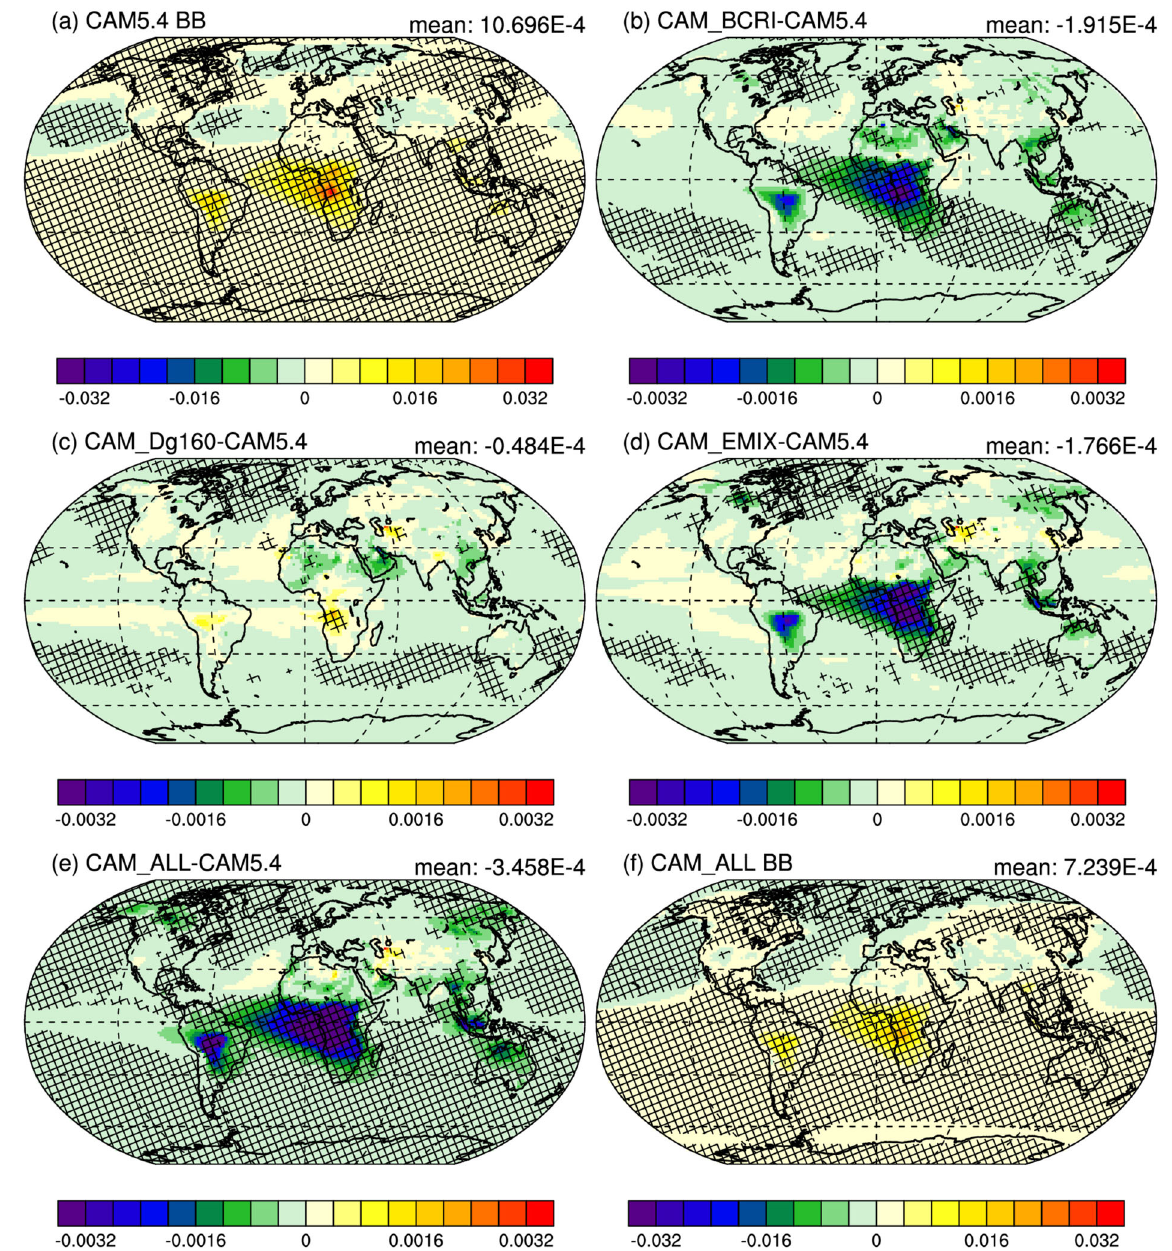
Fig. 6 Modeled biomass burning absorption aerosol optical depth. a default CAM5.4 biomass burning (BB) aerosol absorption optical depth (AAOD), b the difference in AAOD due to changes in BB black carbon refractive index (CAM_ BCRI – CAM5.4), c the difference in AAOD due to increasing BB aerosol size (CAM_Dg160 – CAM5.4), d the difference in AAOD due to treating fresh BB aerosol as externally mixed (CAM_EMIX – CAM5.4), e the difference in AAOD due to all of the previous changes (CAM_ALL – CAM5.4), and f the AAOD of BB with all of the previous changes (CAM_ALL). Hatching indicates regions where the change over the ensemble years is signi fi cant to the 0.05 level. Note difference in color